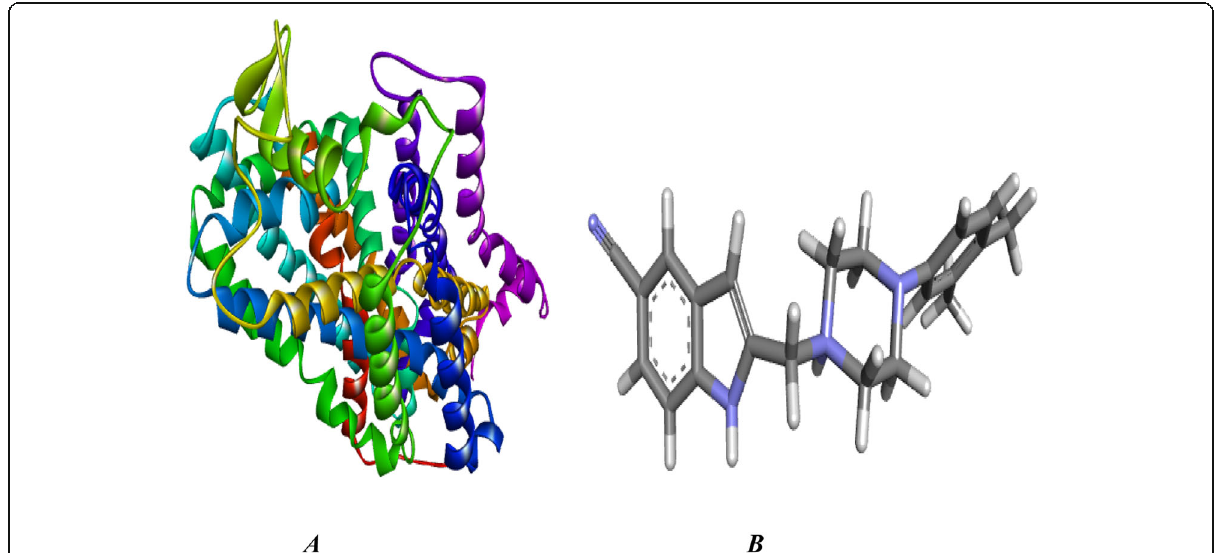
Fig. 2 a 3D structure of the prepared protein target (PDB: 4m48) and b 3D structure of a prepared ligand